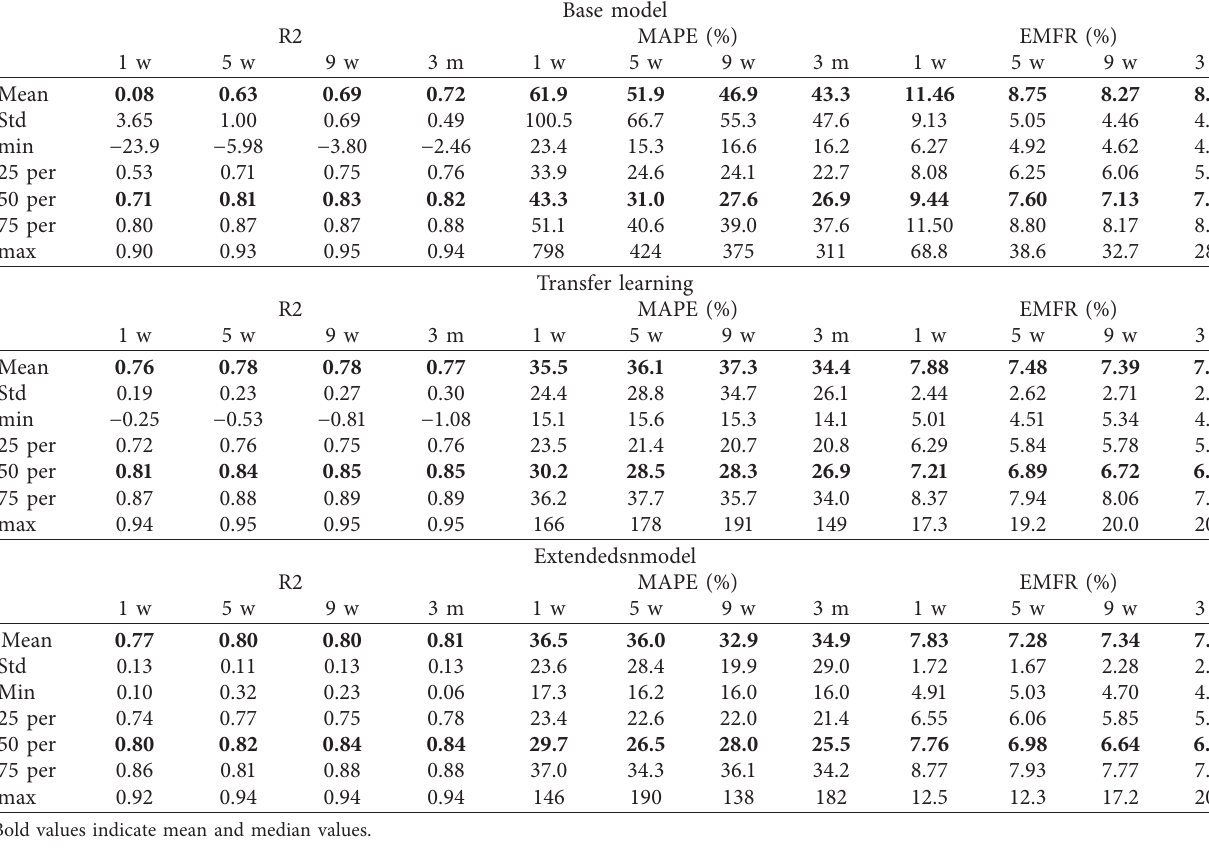
Table 3: The detailed results regarding the size of the New Hampshire dataset.